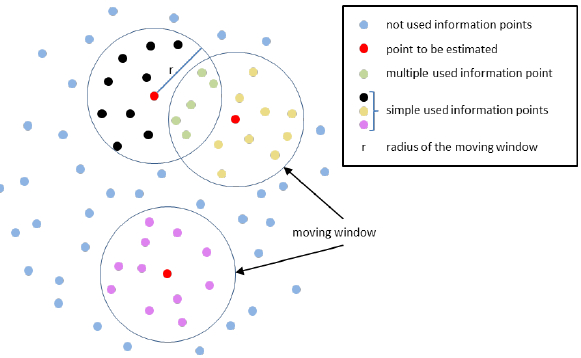
Figure 1. Initial situation before subsequent Kriging analysis (fig. from Laun,